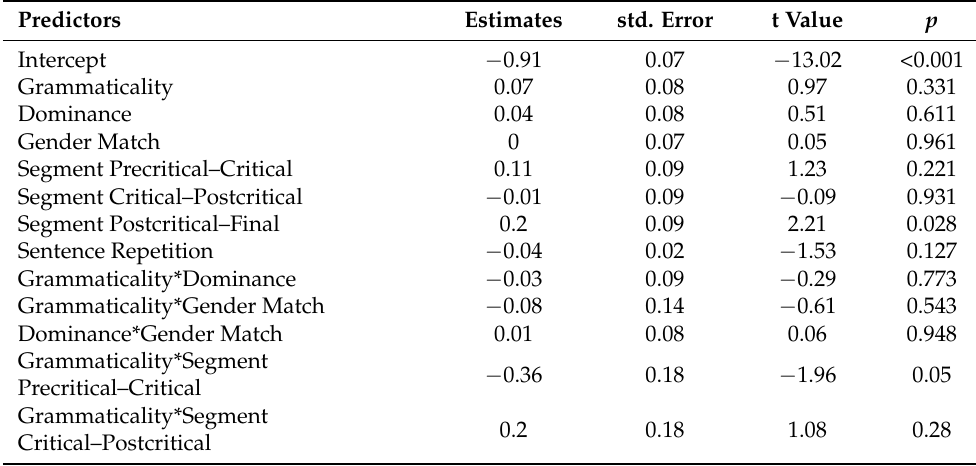
Table A16. Summary of the model with the bilingual children and sentence repetition and dominance as